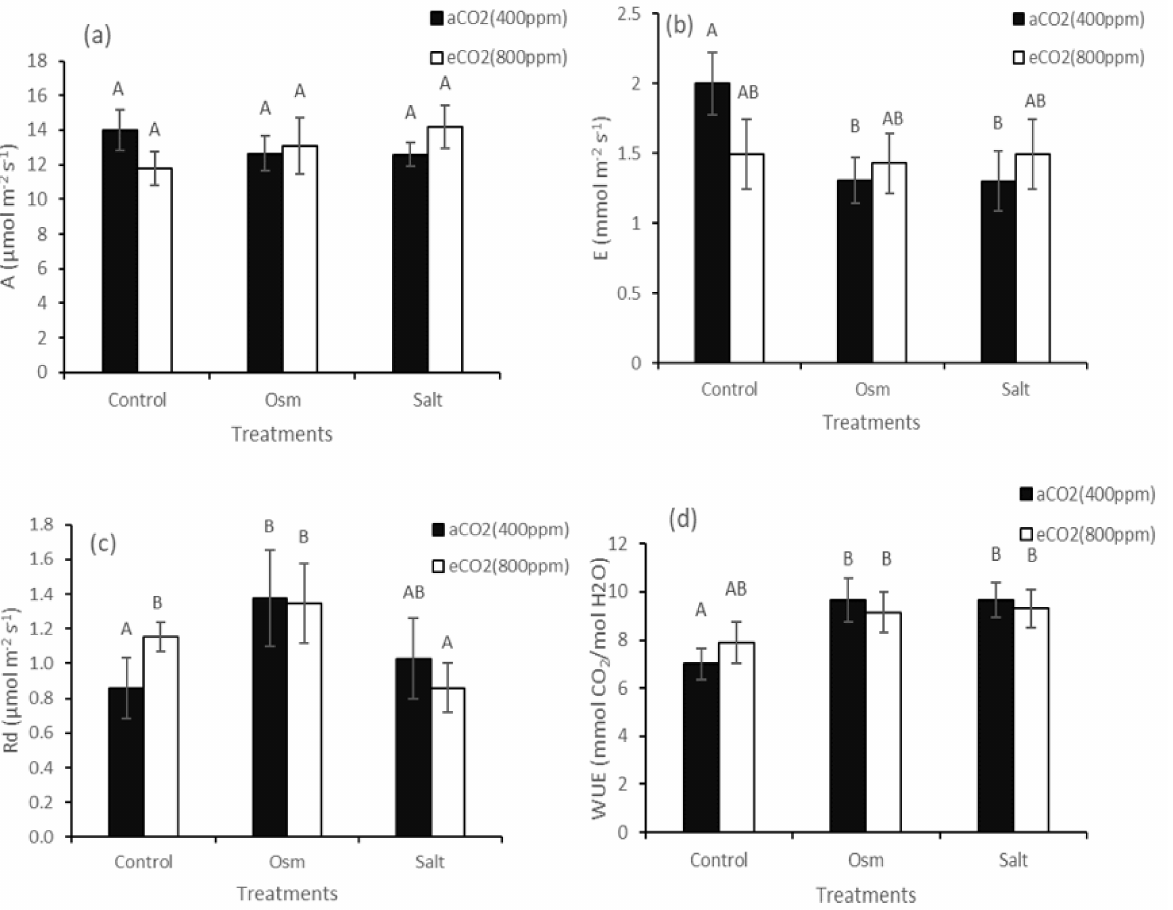
Figure 2. Apparent photosynthesis ( a ), transpiration ( b ), dark respiration ( c ), and water-use efficiency ( d ) in plant leaves of C 4 Kochia prostrata at different CO 2 concentrations (400 and 800 ppm) under moderate (–0.6 MPa) PEG-induced osmotic stress (Osm) and salinity (Salt) similar in osmotic potential (200 mM NaCl). The values are means ( ± SE) of seven replicates. Different letters above the bars represent significant differences at the p < 0.05 (Tukey’s pairwise comparison). aCO 2 —ambient CO 2 concentration; eCO 2 —elevated CO 2